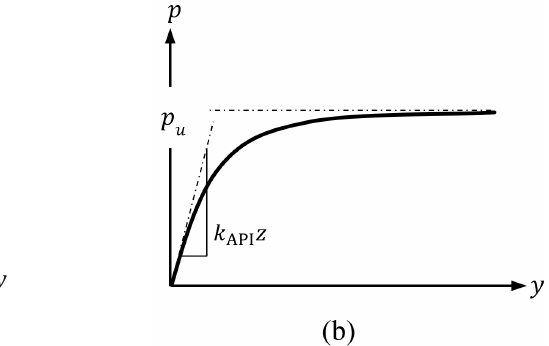
Table 1: Proposed formulae to enhance p–y curves. The initial stiffness E * py